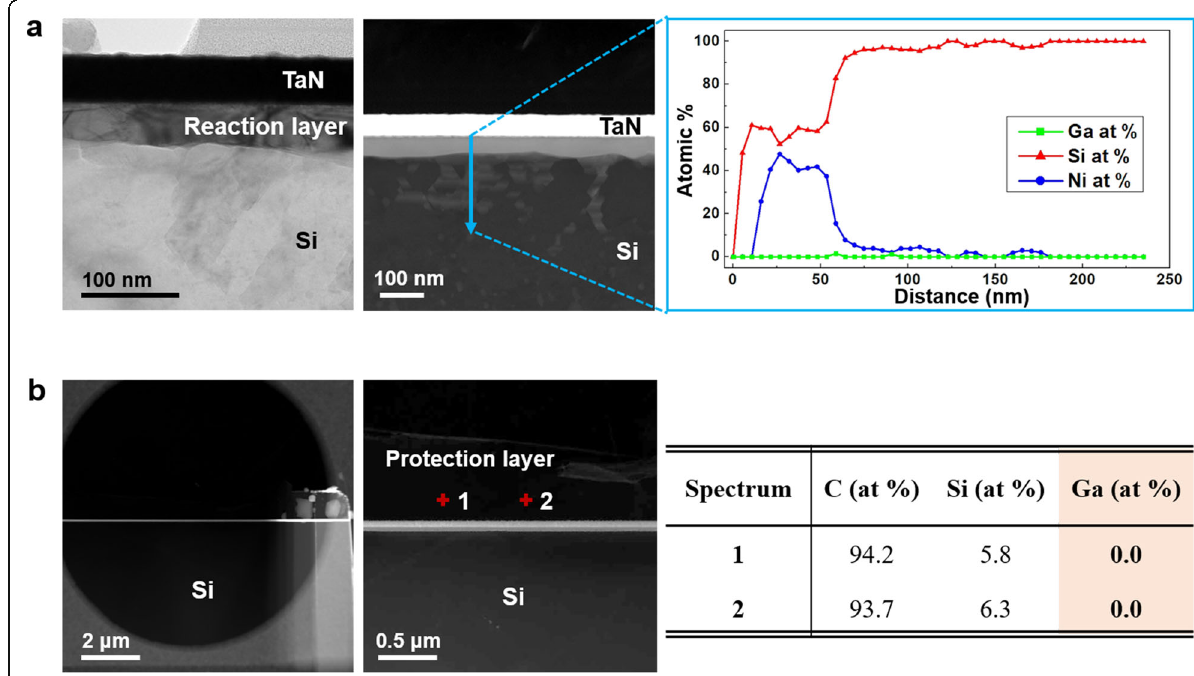
Fig. 4 Result after the specimen attached to the FIB lift-out grid is subjected to Ar + ion milling. a The TEM/HAADF-STEM images and EDS line profile of the heat-treated graphene-encapsulated TaN/Ni/Si thin-foil specimen. b The TEM/HAADF-STEM images and chemical composition of the heat-treated graphene-encapsulated TaN/Er/Si thin-foil